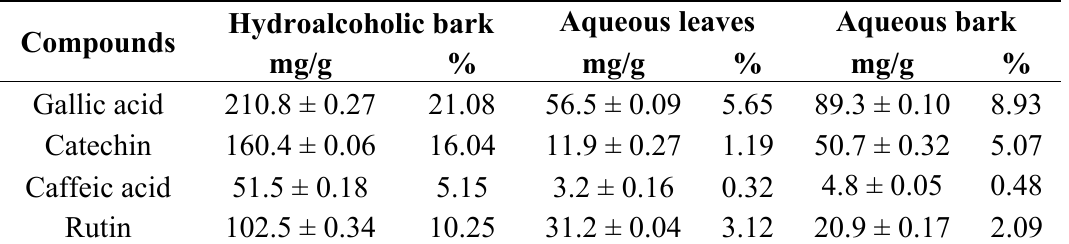
Results are expressed as mean ± SEM performed in